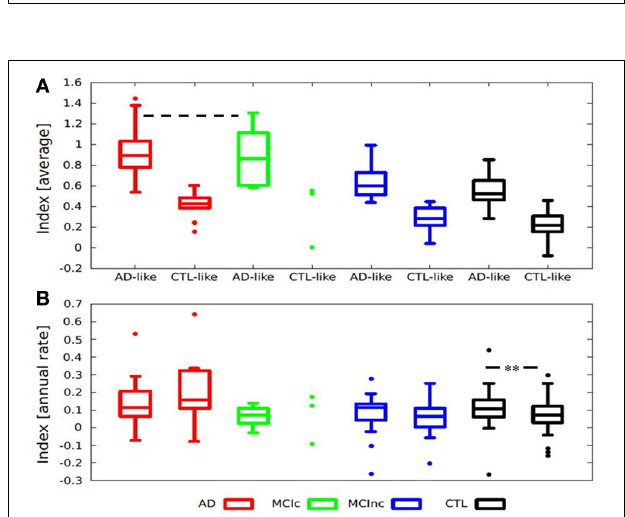
FIGURE 4 | Box-plots illustrating the distribution of (A) Average index according to diagnosis and stratified by pattern of atrophy, all groups are significantly different except for AD-like AD and AD-like MCI-c (--- Two-sided T -test p = 0 . 76). (B) Index annual rate of change stratified by diagnosis and pattern of atrophy. Index annual rate of change = index at 1-year − index at baseline. ∗∗ Mann-Whitney p = 0 . 028; Average index = (Index at baseline + index at 1-year)/2. AD, Alzheimer disease; MCI-c, MCI converter; MCI-nc, MCI non-converter (stable); MCI, mild cognitive impairment; CTL, healthy control.